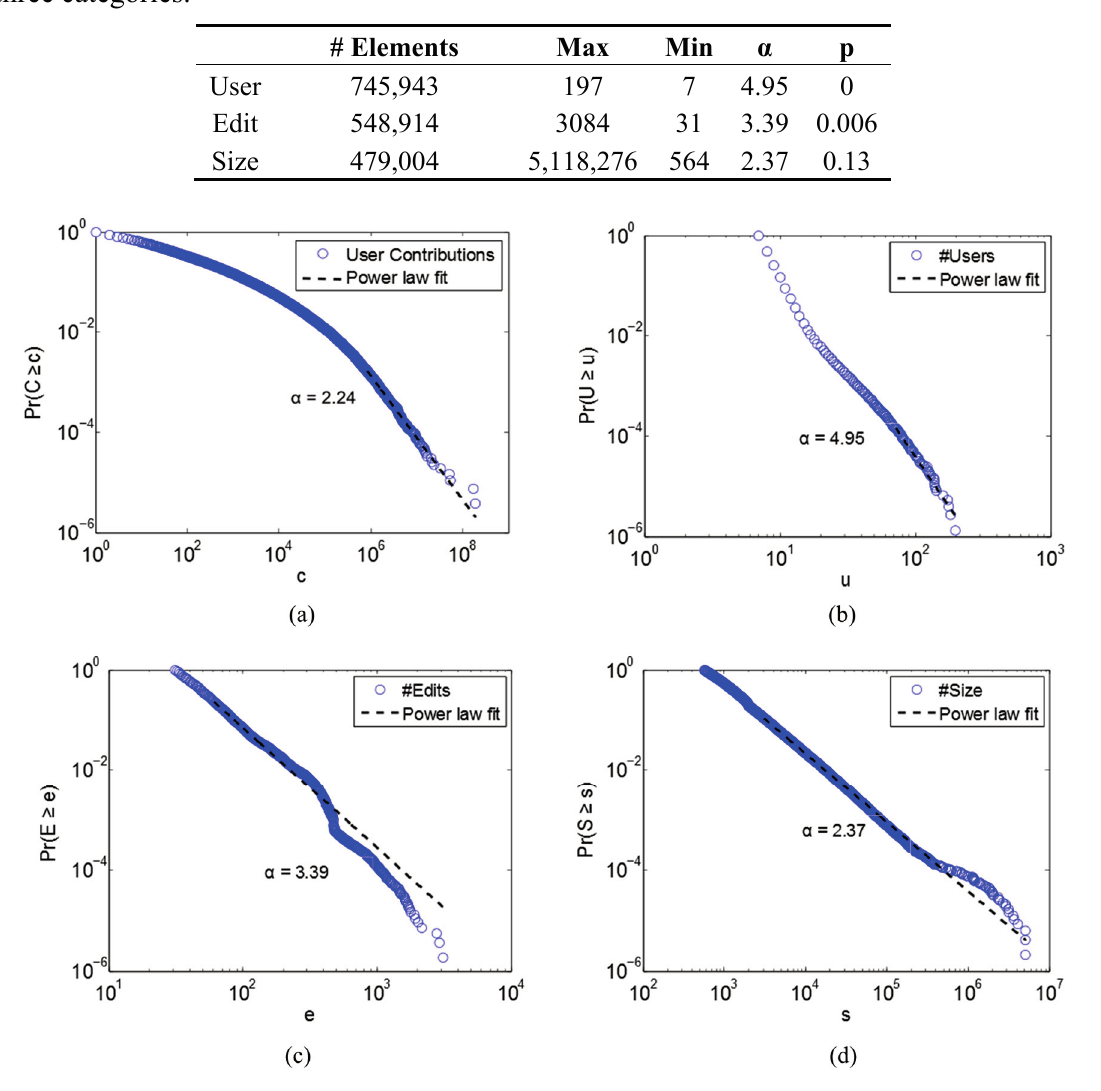
Figure 3. Power-law distributions of user contributions: ( a ) number of users; ( b ) number of edits; and ( c ) number of sizes ( d ) of each element. The data for (b), (c), and (d) are selected from the top hierarchies of all elements. (b) and (c) are not power-law distributed because both α values are larger than 3, but they are heavy-tailed, illustrated by the high ht-index shown in the